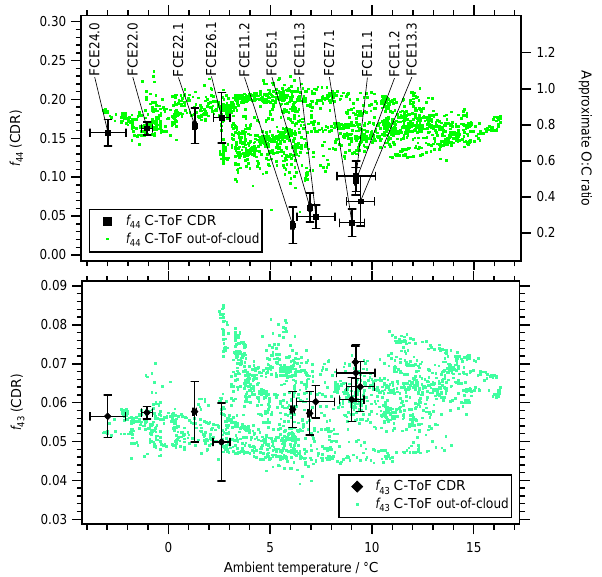
Figure 9. Upper panel: ratio m/z 44 to total organics ( f 44 ) of cloud droplet residues (CDRs) and out-of-cloud aerosol (both measured with the C-ToF-AMS) as a function of temperature. The approxi- mate O:C ratio inferred from f 44 is given on the right axis. Lower panel: same graph but for f 43